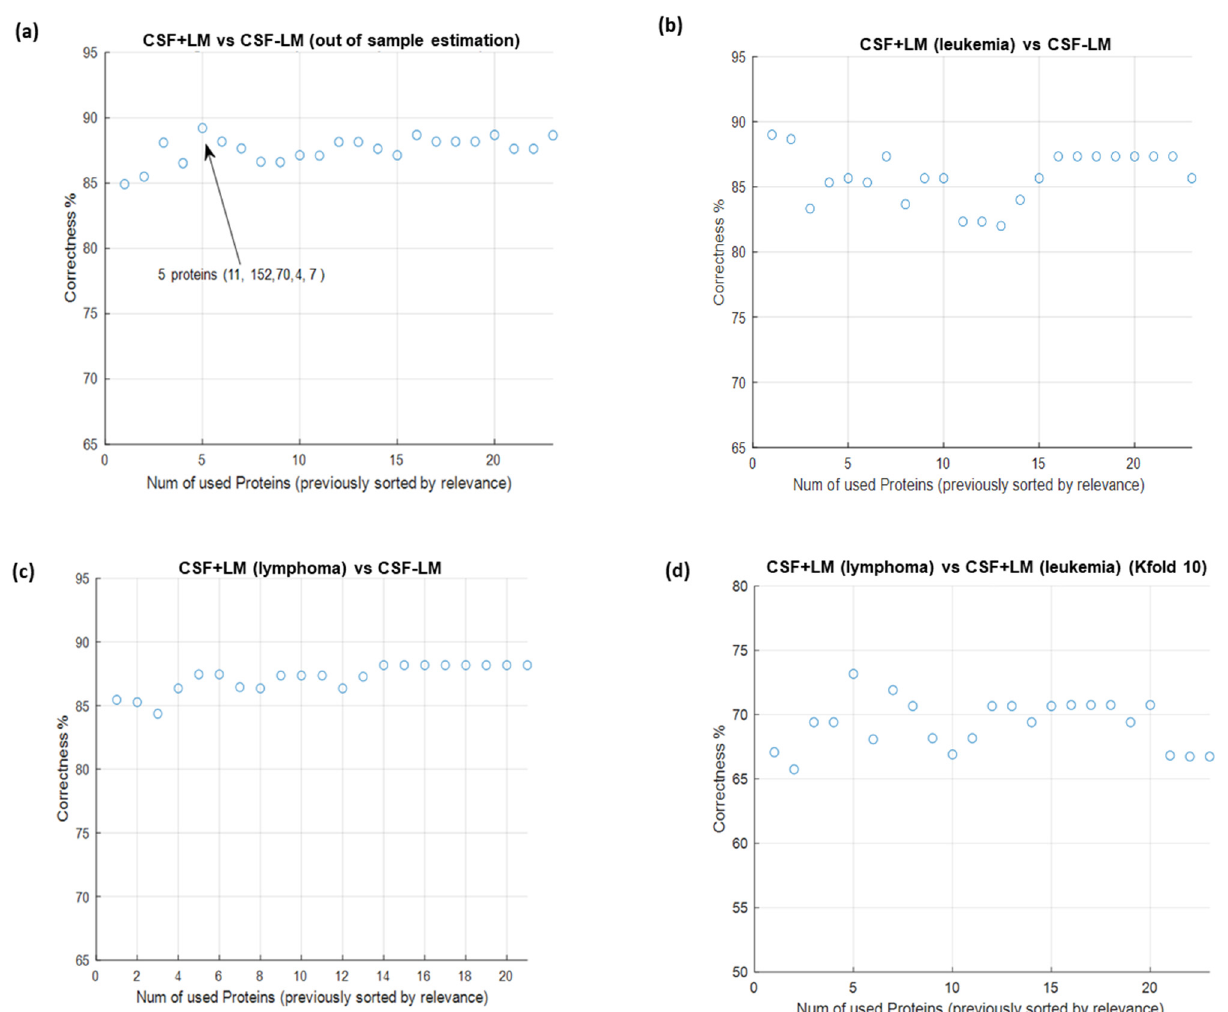
Figure 6. Correctness of four ‘two-groups’ classification problems by using Support Vector Machine (SVM). The features were previously selected and ranked by relevance using maximum-relevance—minimum-redundancy (mRMR). To generate the plots, SVM was progressively run with the most relevant feature, then with the two most relevant features, then with the three most relevant, etc. All results were out-of-sample estimations using k-fold cross validation. ( a ) Correctness of CSF + LM vs. CSF – LM. ( b ) Correctness of CSF + LM (leukemia) vs. CSF – LM. ( c ) Correctness of CSF + LM (lymphoma) vs. CSF – LM. ( d ) Correctness of CSF + LM (lymphoma) vs. CSF + LM (leukemia).